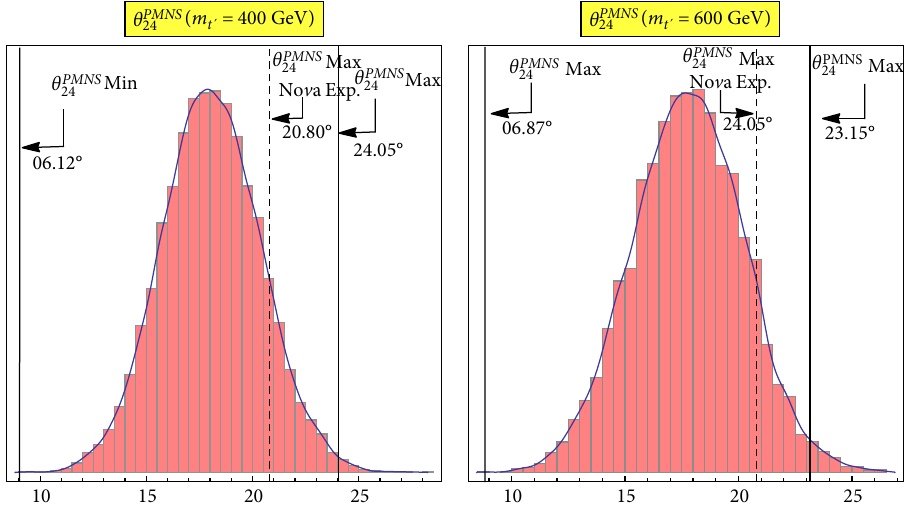
Figure 5: Probability density distribution of 𝜃 𝑃𝑀𝑁𝑆